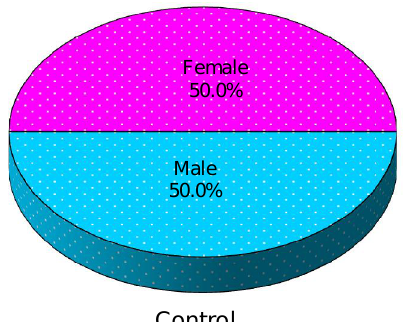
Figure 2: The percentage of gender studied showed that the control group with 50% male and 50% female when compared to case group male 54% and 46% female.